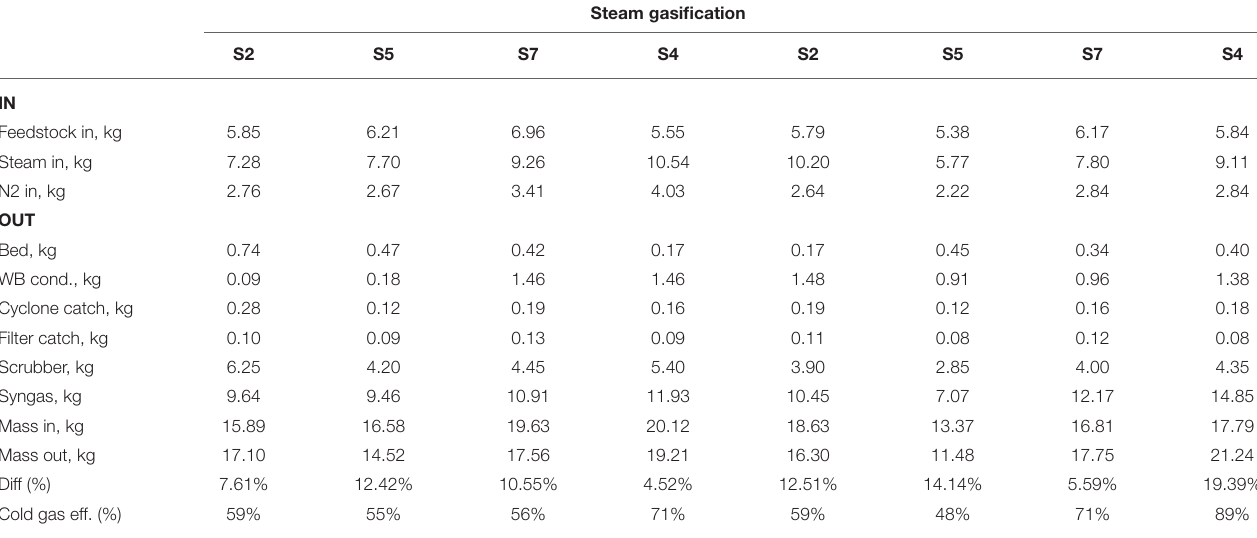
TABLE 6 | Mass balances (kg) for steam gasification.